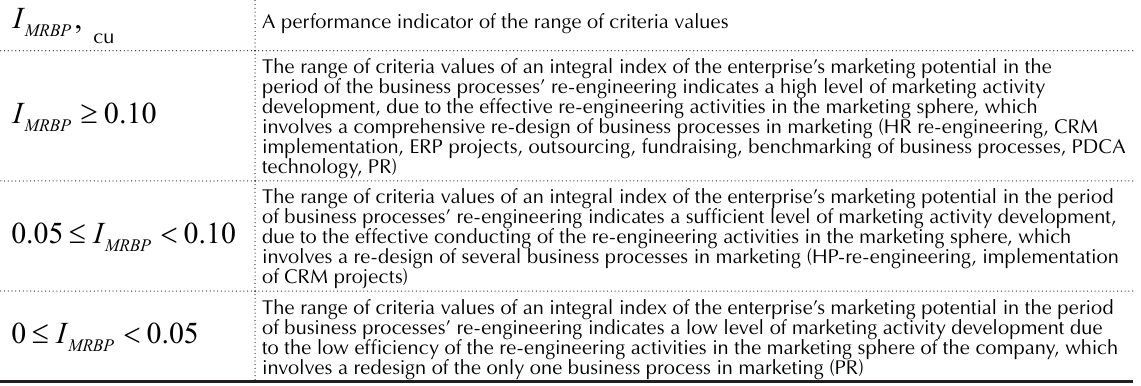
Table 4. Ranges of criteria values of an integral index of the marketing potential of JSC Sumy Plant Nasosenergomash in the period of business processes’ reengineering , MRBP